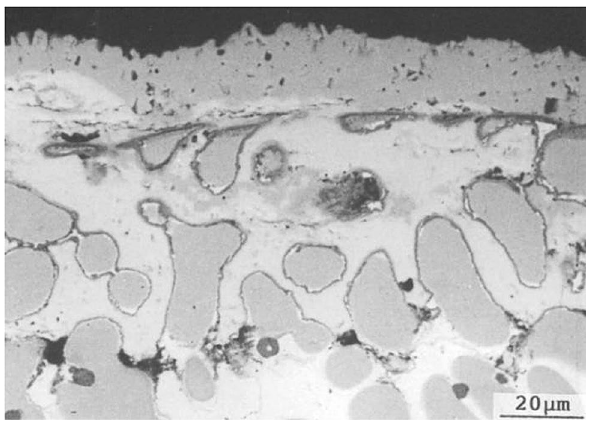
Fig. 7 Microstructure with oxidation on surface of Cu–Cr alloy above 700 °C [21]